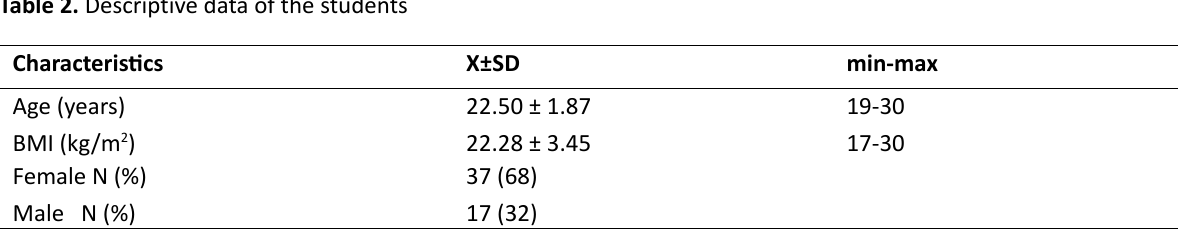
Table 3. The comparison of sleep quality, fatigue severity, neck disability, and head posture values pre and post exercise